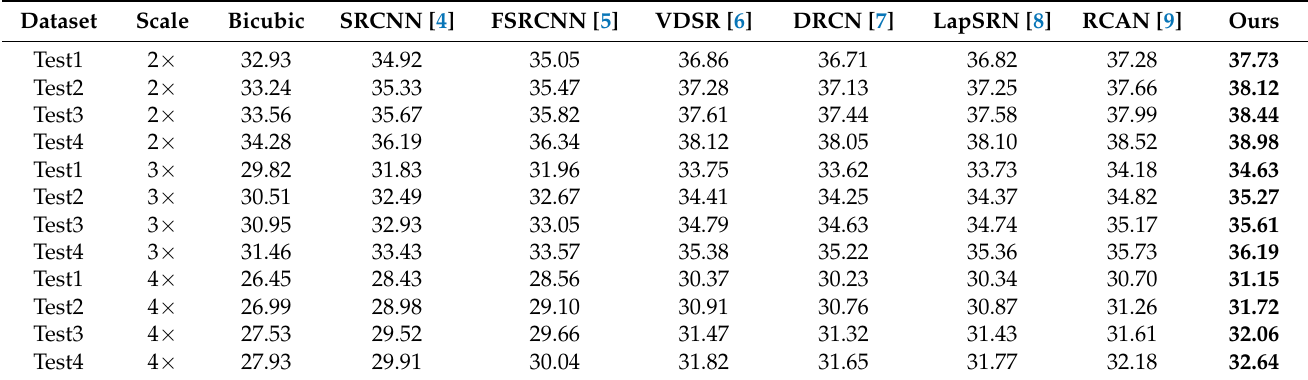
Table 3. Average PSNR for different algorithms at Test1, Test2, Test3 and Test4